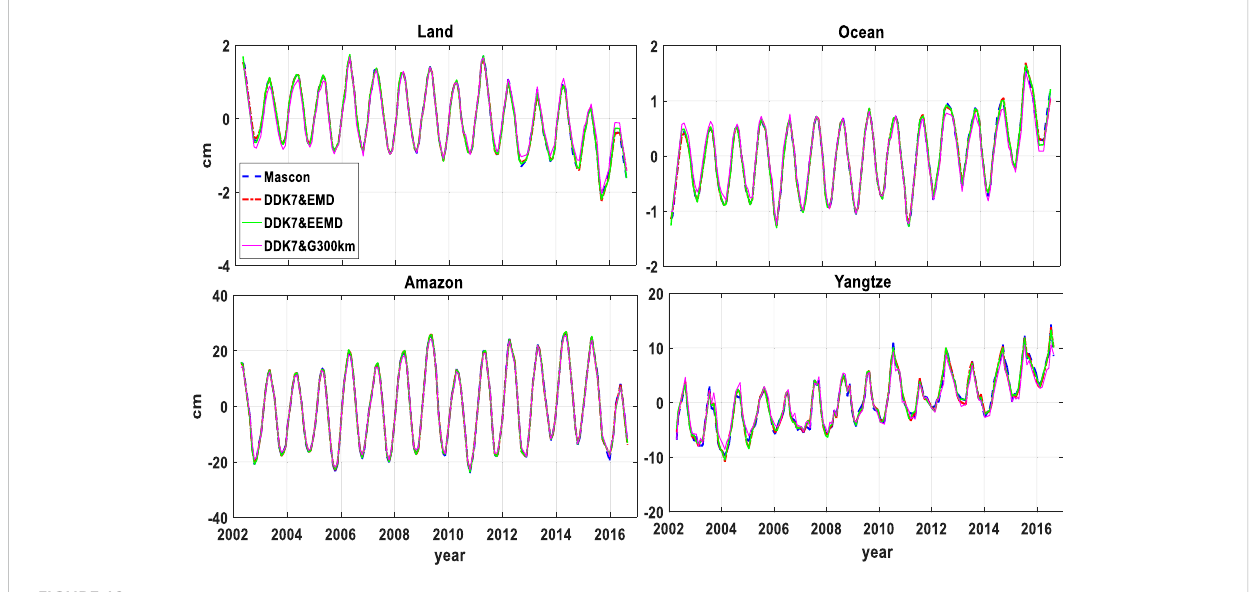
FIGURE 12 Mean mass change series of three fi ltering approaches in four regions over April 2002 to August 2016.